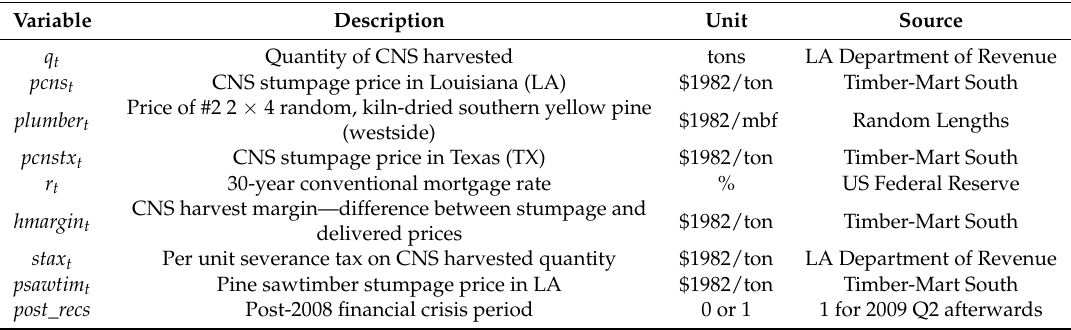
Table 1. Econometric variables in the study, their descriptions, and